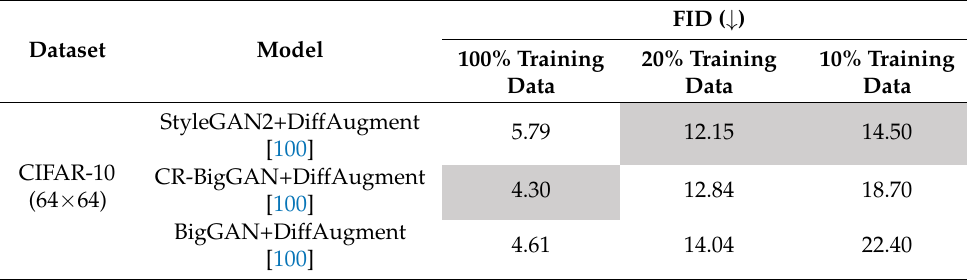
Table 9. FID of different models trained with the CIFAR-10 dataset. StyleGAN2 performs better than CR-BigGAN and BigGAN models when there is little training data. FIDs are measured using 100%, 20%, and 10% training data of the CIFAR-10 dataset. The lower the FID value, the better the performance.